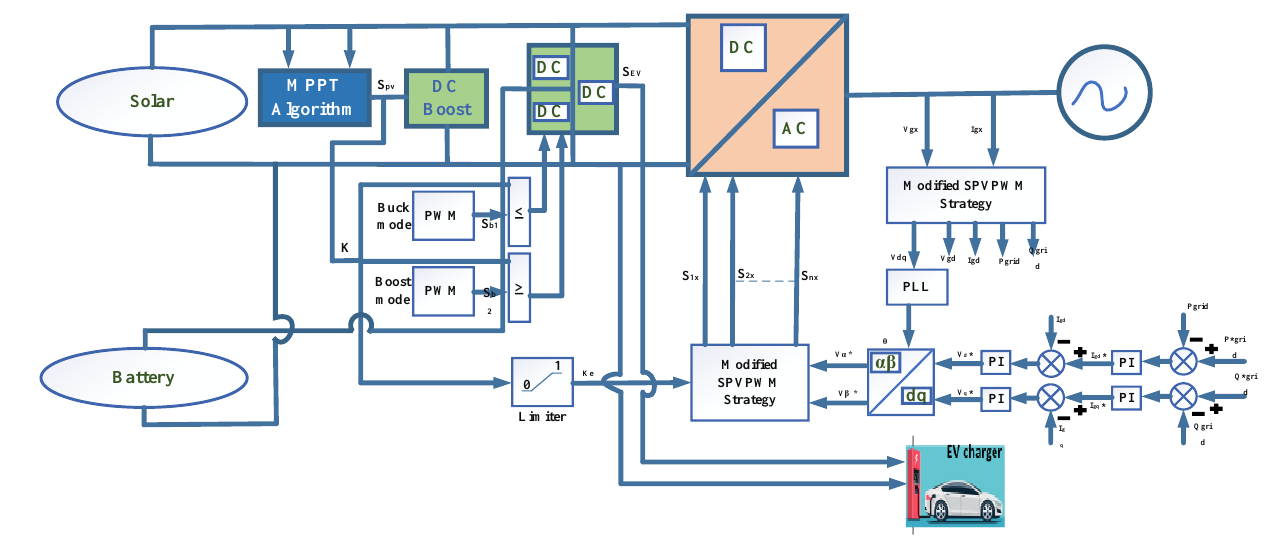
Figure 15. Multiport Converter control schema.